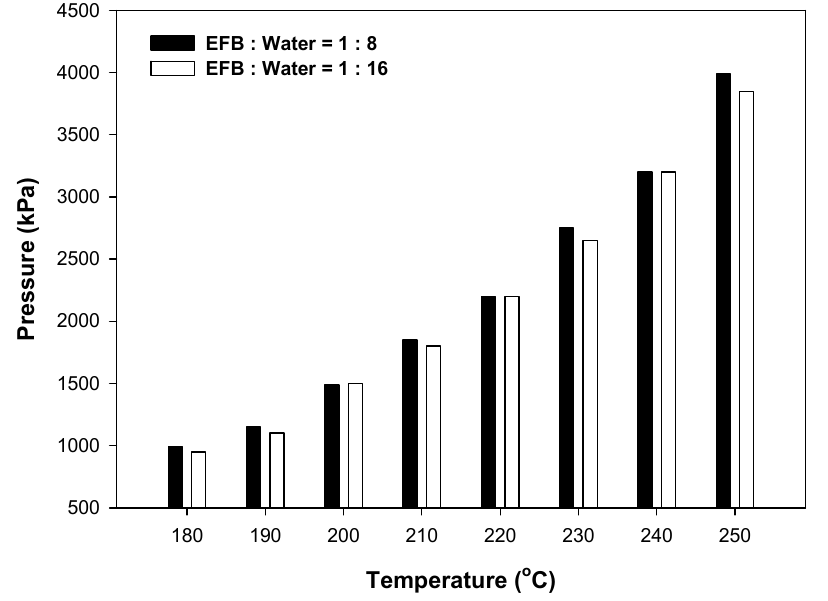
Figure 3. Change in pressure with reaction temperature for different water